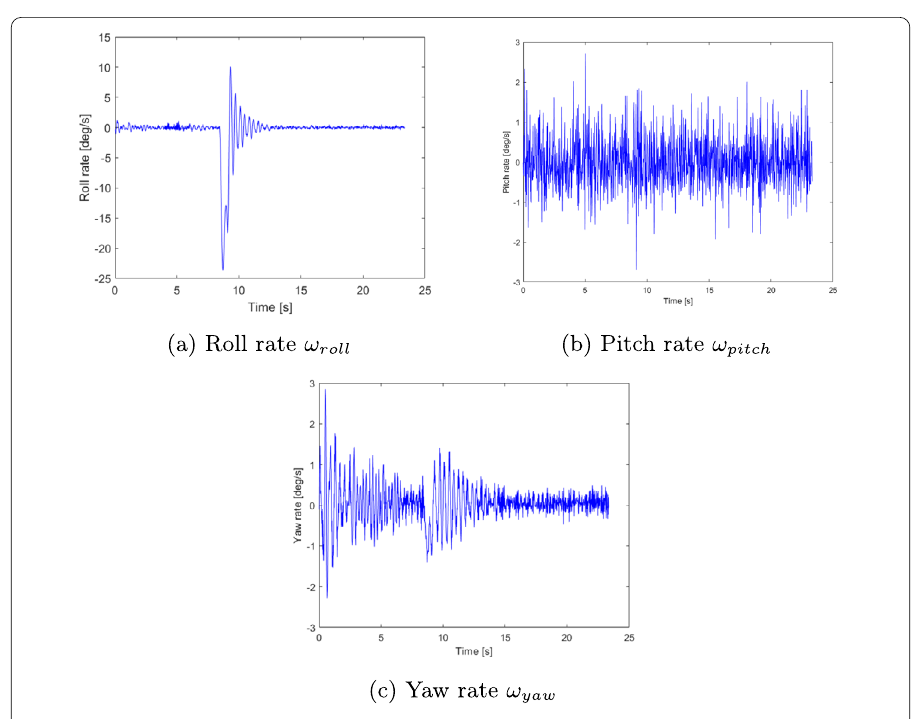
Figure 7 Raw angular velocity data for roll, pitch and yaw axes of link L